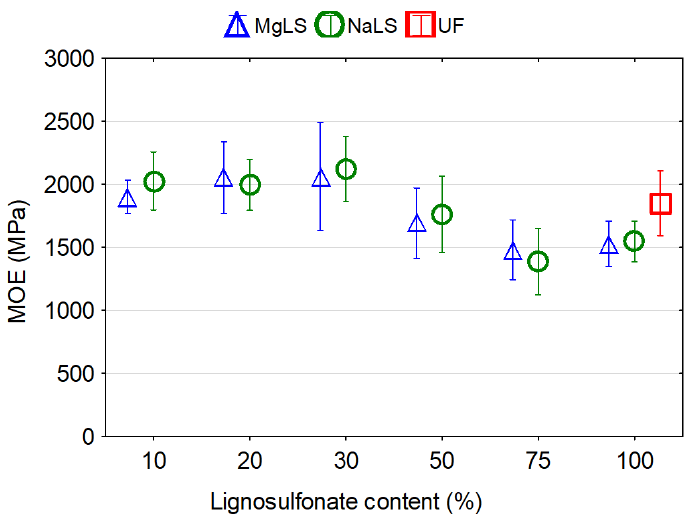
Figure 9. Modulus of elasticity (MOE) of boards made with lignosulfonated-urea-for- maldehyde adhesive.